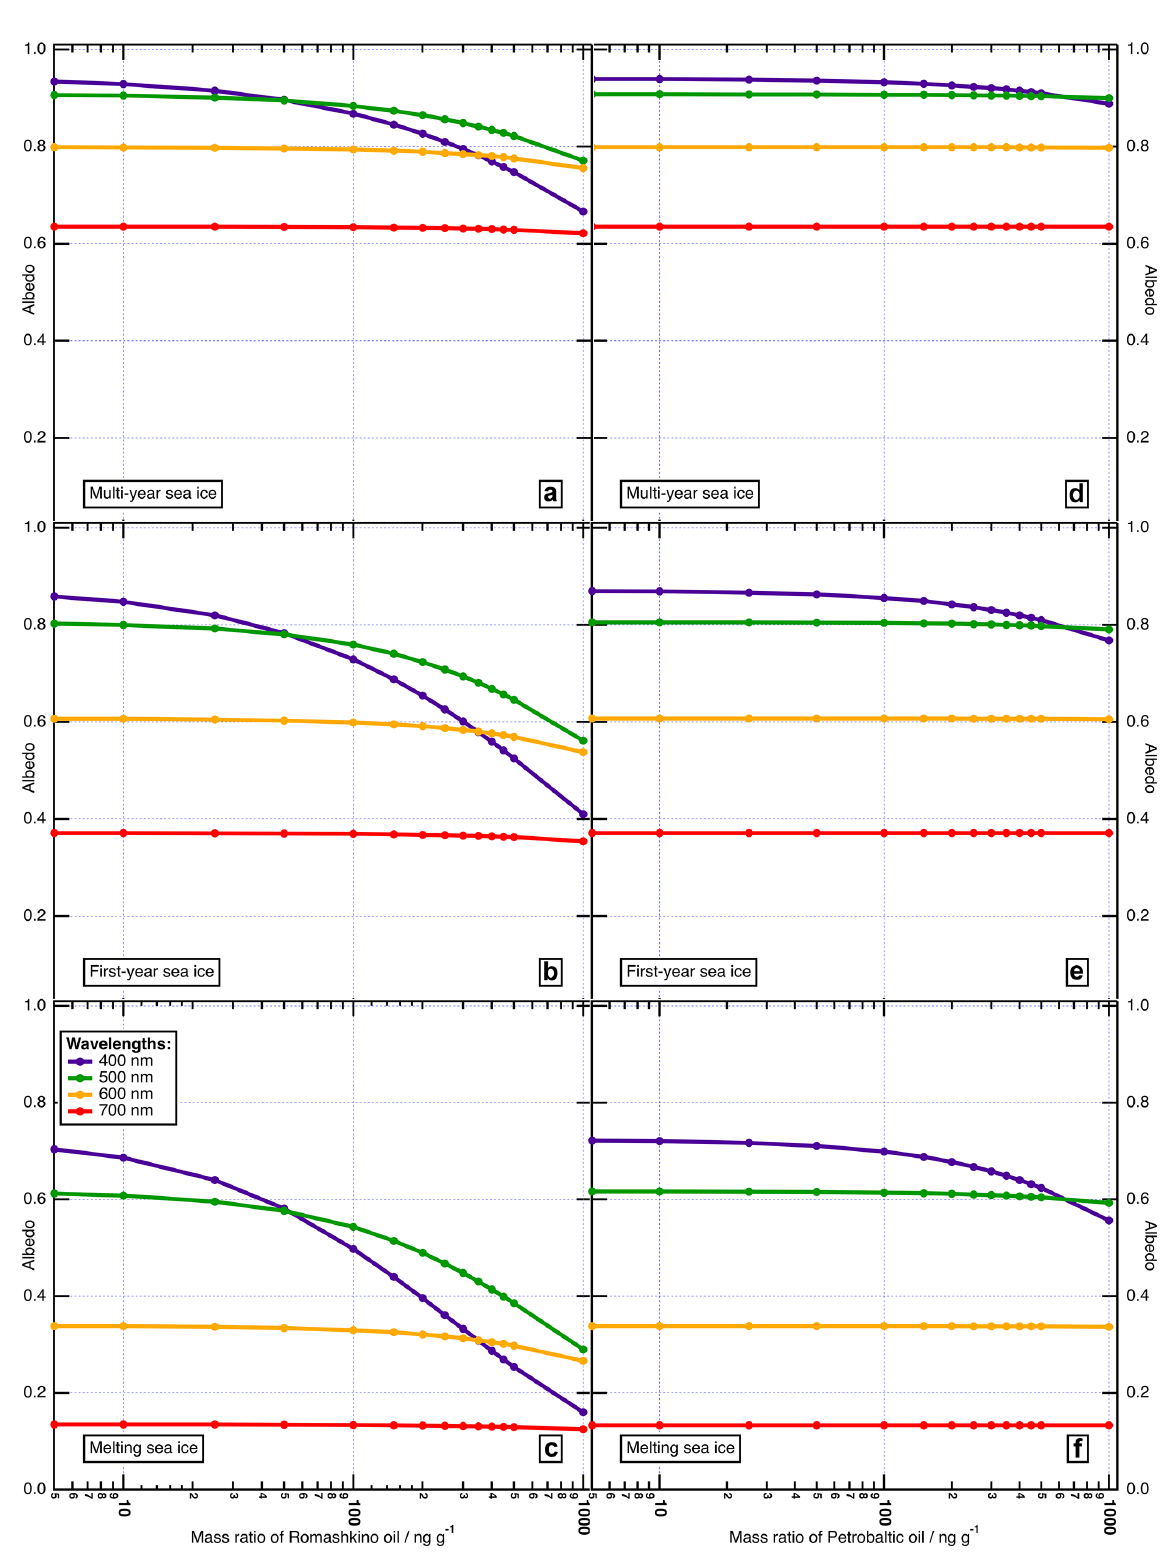
Figure 2. Albedos of multi-year, first-year, and melting sea ice with increasing mass ratios of Romashkino (a–c) and Petrobaltic (d–f) oils (0–1000ngg − 1 ) with a median droplet radius of 0.05µm. The selected wavelengths are 400, 500, 600, and 700nm. The three types of sea ice are quasi-infinite, and their properties are described in Table 1. These data demonstrate a large difference in how responsive each type of sea ice is to increasing mass ratios of Romashkino or Petrobaltic